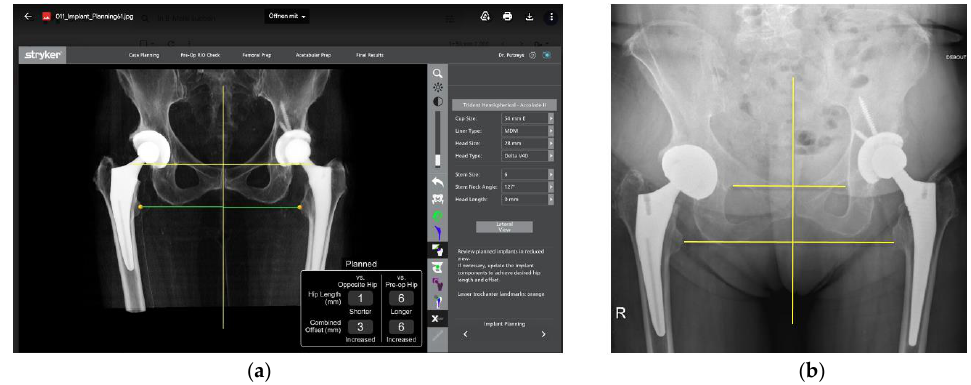
Figure 10. VROM in flexion with new femoral broach version of 16 degrees with no further evidence of impingement.